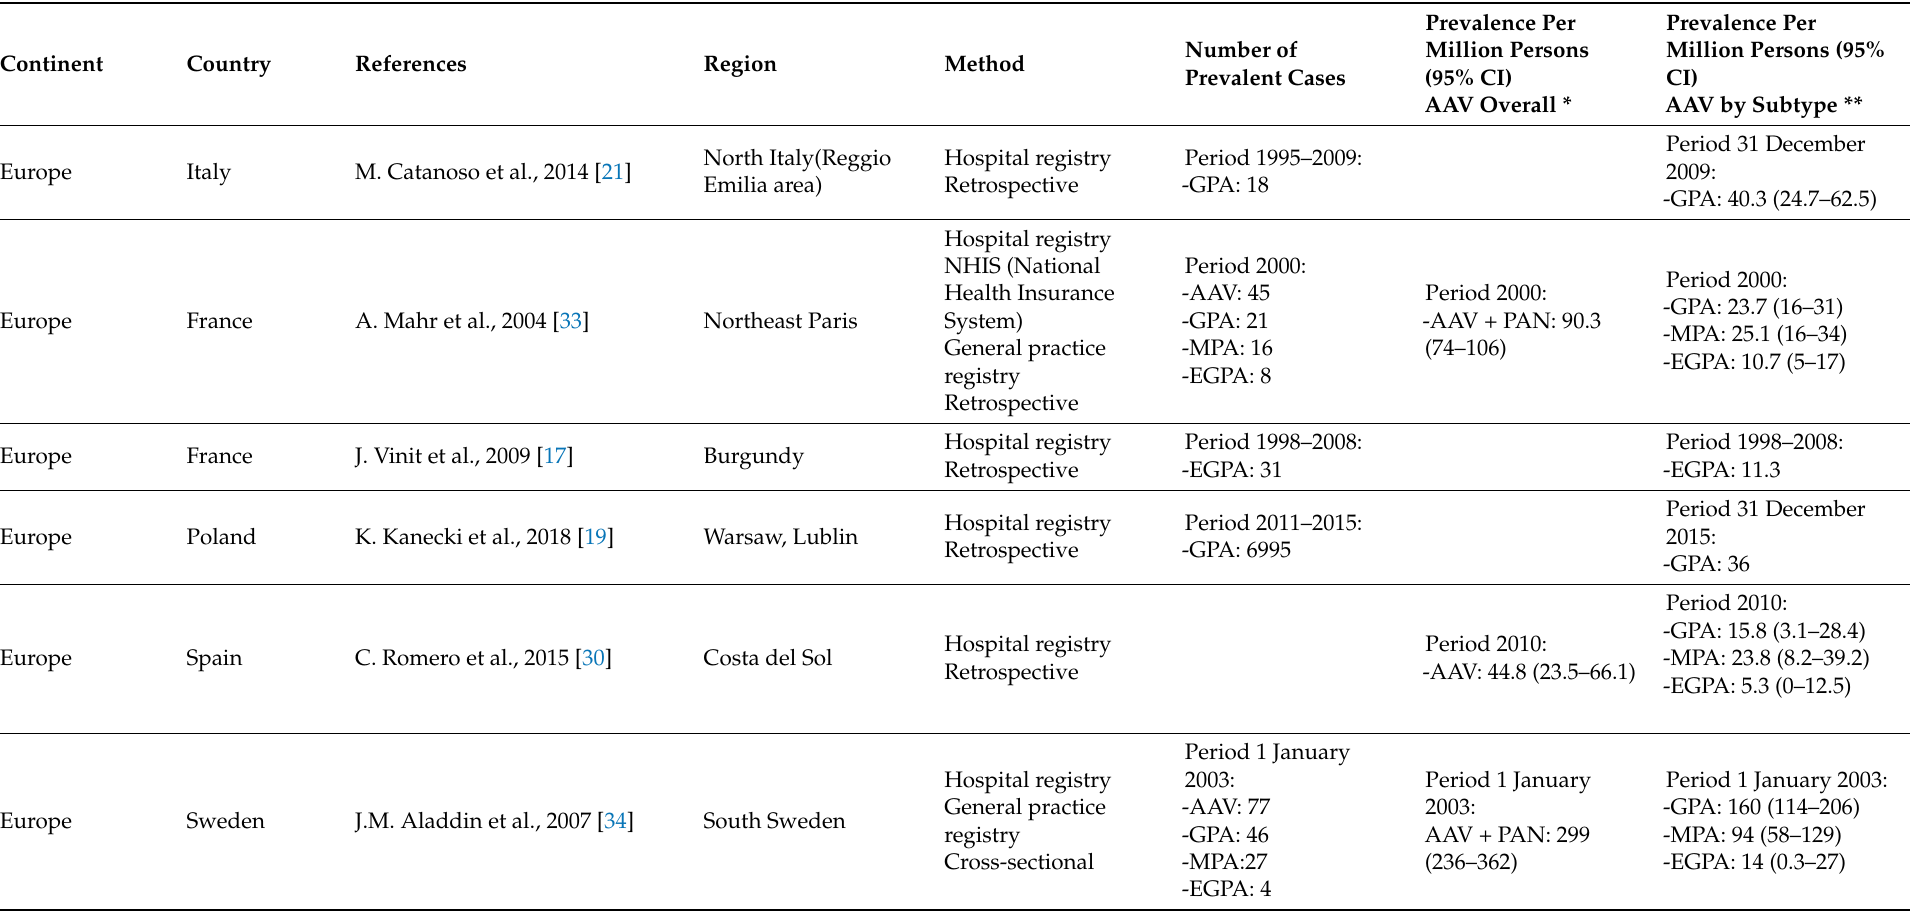
Table 5. Worldwide prevalence of